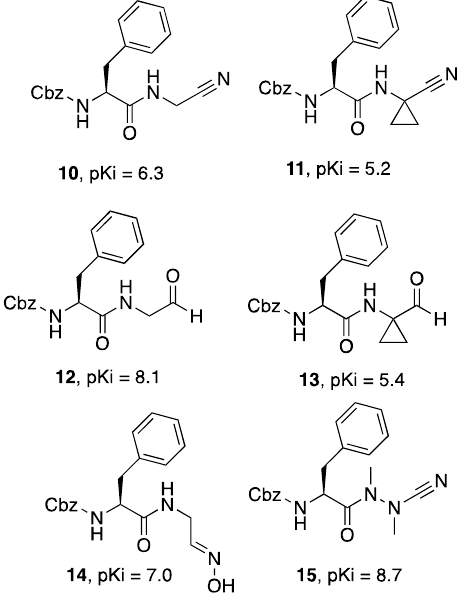
Figure 4. Exploration of different warheads in dipeptidic Cz inhibitors 10 – 15 .